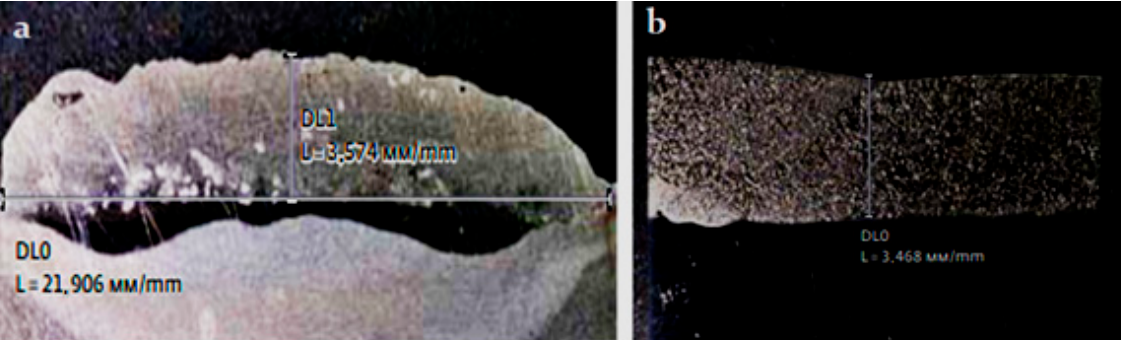
Figure 4. Study of the deposited material on the samples: ( a )—single surfacing track in one pass, ( b )—overlap zone of the deposited layers (transitional).